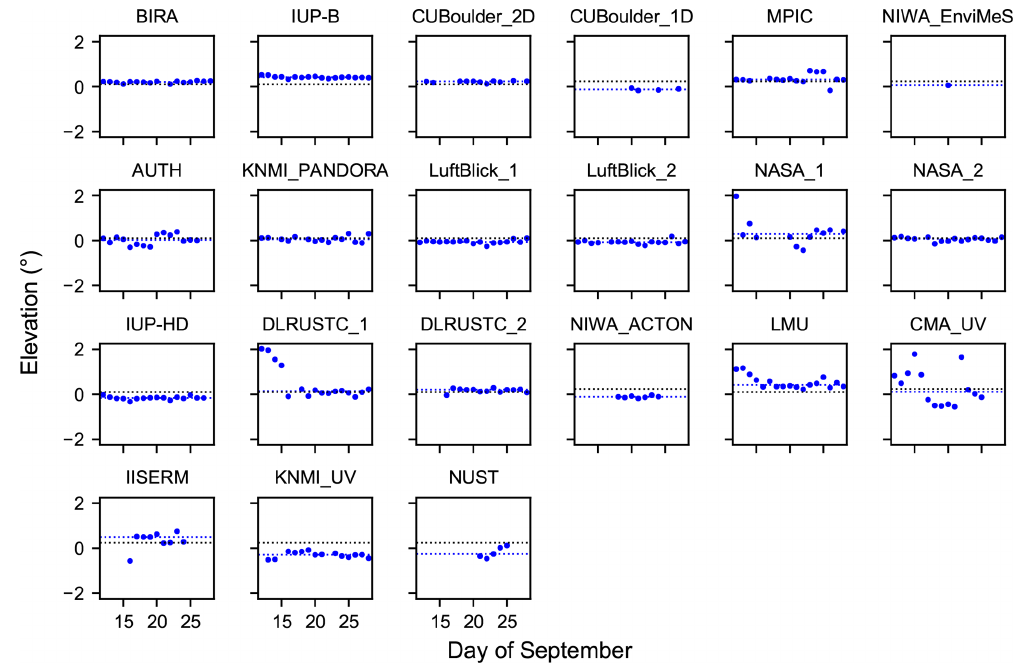
Figure 16. Overview of the daily results of the horizon scans for all participating instruments at 340nm. Additionally, in each subplot the median horizon elevation (dashed blue lines) and expected horizon elevation (dashed black lines) for the corresponding instrument are